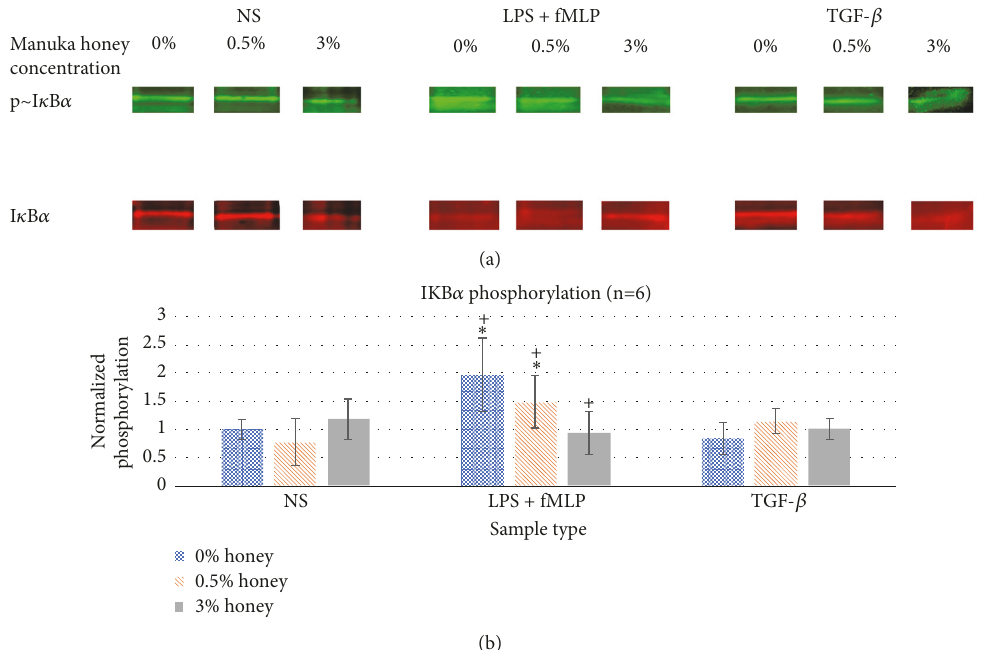
Figure 5: (a) Representative Western blot bands of p ∼ I 𝜅 B 𝛼 and total I 𝜅 B 𝛼 for each sample type. (b) I 𝜅 B 𝛼 phosphorylation expressed as the ratio of p ∼ I 𝜅 B 𝛼 to total I 𝜅 B 𝛼 , normalized to NS 0% honey control. ∗ indicates a statistically significant difference from the NS control at that respective honey level. + indicates a statistically significant difference from the other concentrations of honey for that stimulus group. 𝛼 =0.05, measured via two-way ANOVA with Holm-Sidak post